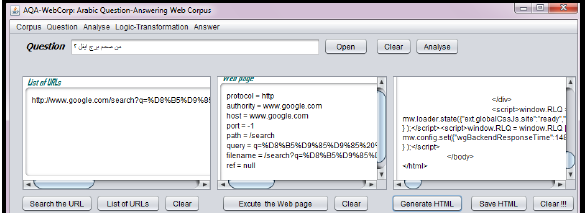
Figure 6. An URL of a web page retaining from the question " !"